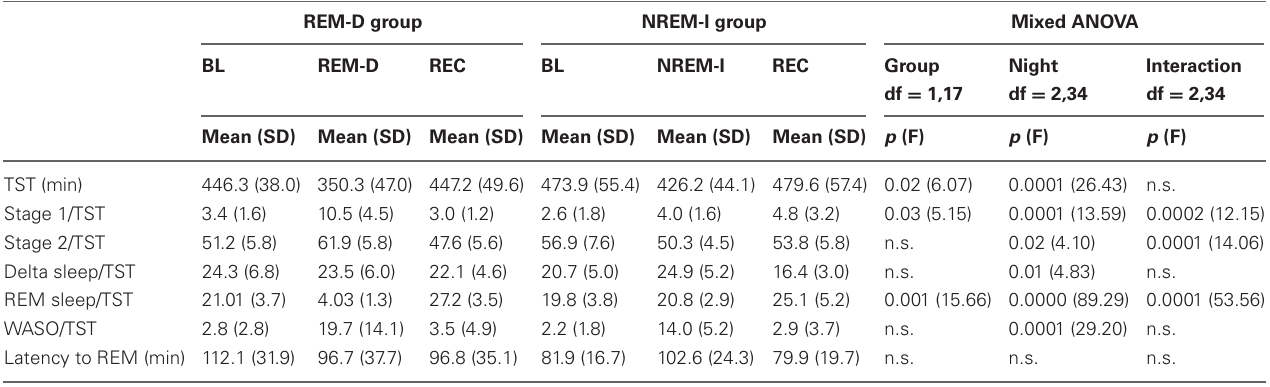
Table 1 | Polysomnographic sleep measures. REM-D group NREM-I group Mixed ANOVA BL REM-D REC BL NREM-I REC Group Night Interaction df = 1,17